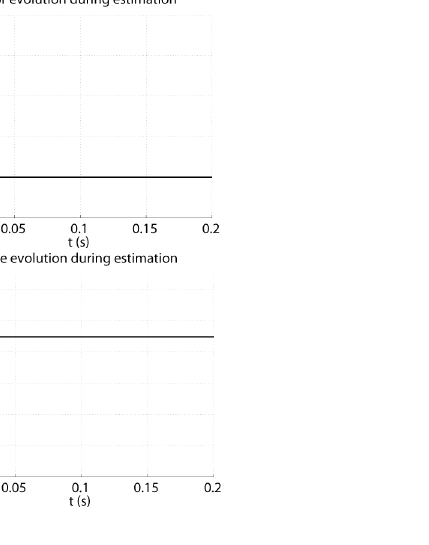
Fig 12. Offline parameters estimation